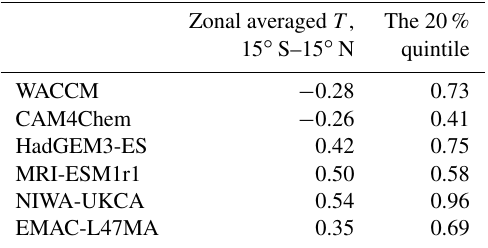
Table 2. Note that the pressure level for each model differs due to data availability, and the levels used for this chart are indicated in Fig. 2. Correlation coefficient ( R ) between entry